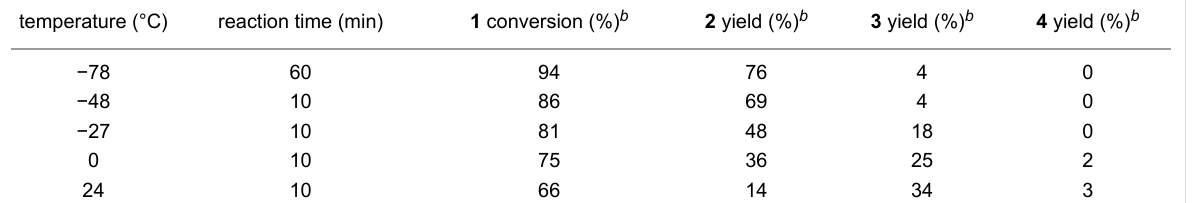
Table 1: Br-Li exchange reaction of 2,2′-dibromobiphenyl ( 1 ) using a conventional macrobatch system. a